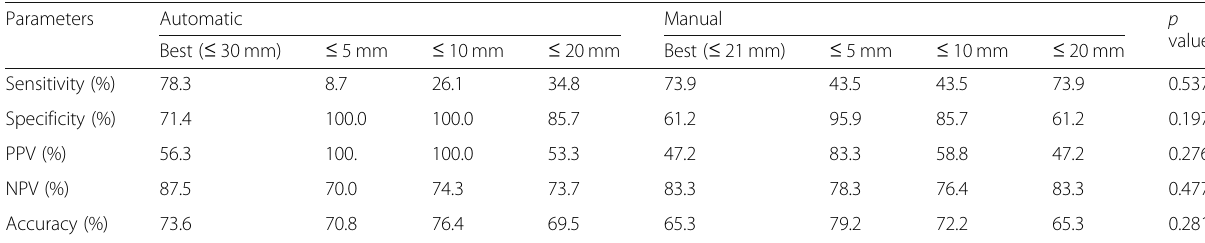
Table 2 Diagnostic performance of the two different methods for computing tumour-to-nipple-areola complex distance at different cut-off values